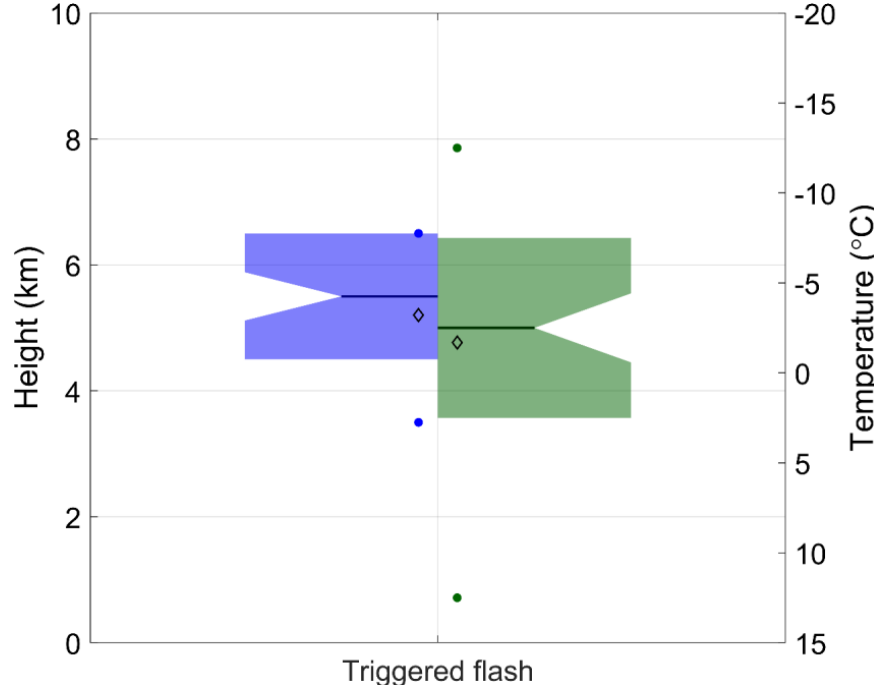
Figure 5. Distribution of the peak height of TLF sources (blue on the left) and ambient temperature (green on the right). The upper and lower solid dots indicate the maximum and minimum values, respectively. The upper and lower boundaries of the colored area represent the 75th and 25th percentile values, respectively; the black horizontal lines represent the medians; and the diamonds indicate the means.